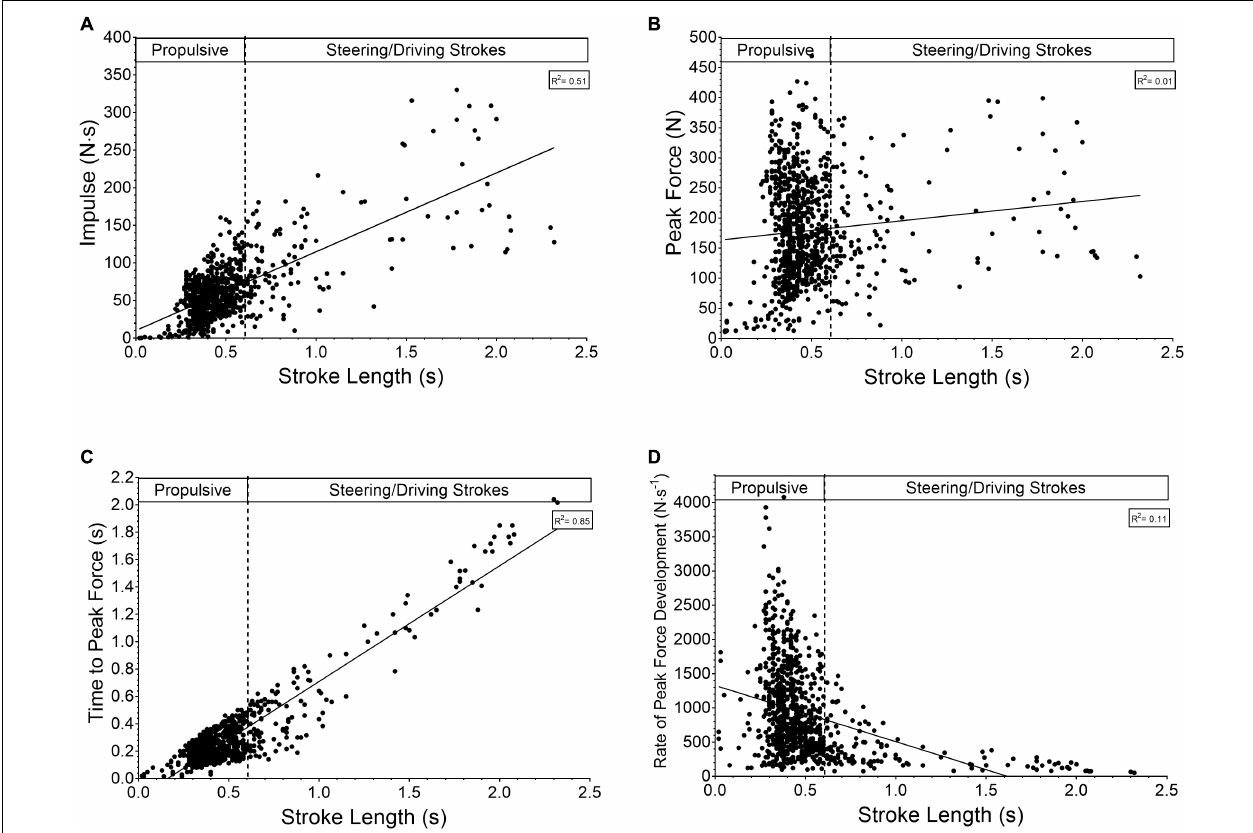
FIGURE 5 | Relationship between stroke length and (A) impulse, (B) peak force, (C) time to peak force, and (D) rate of peak force